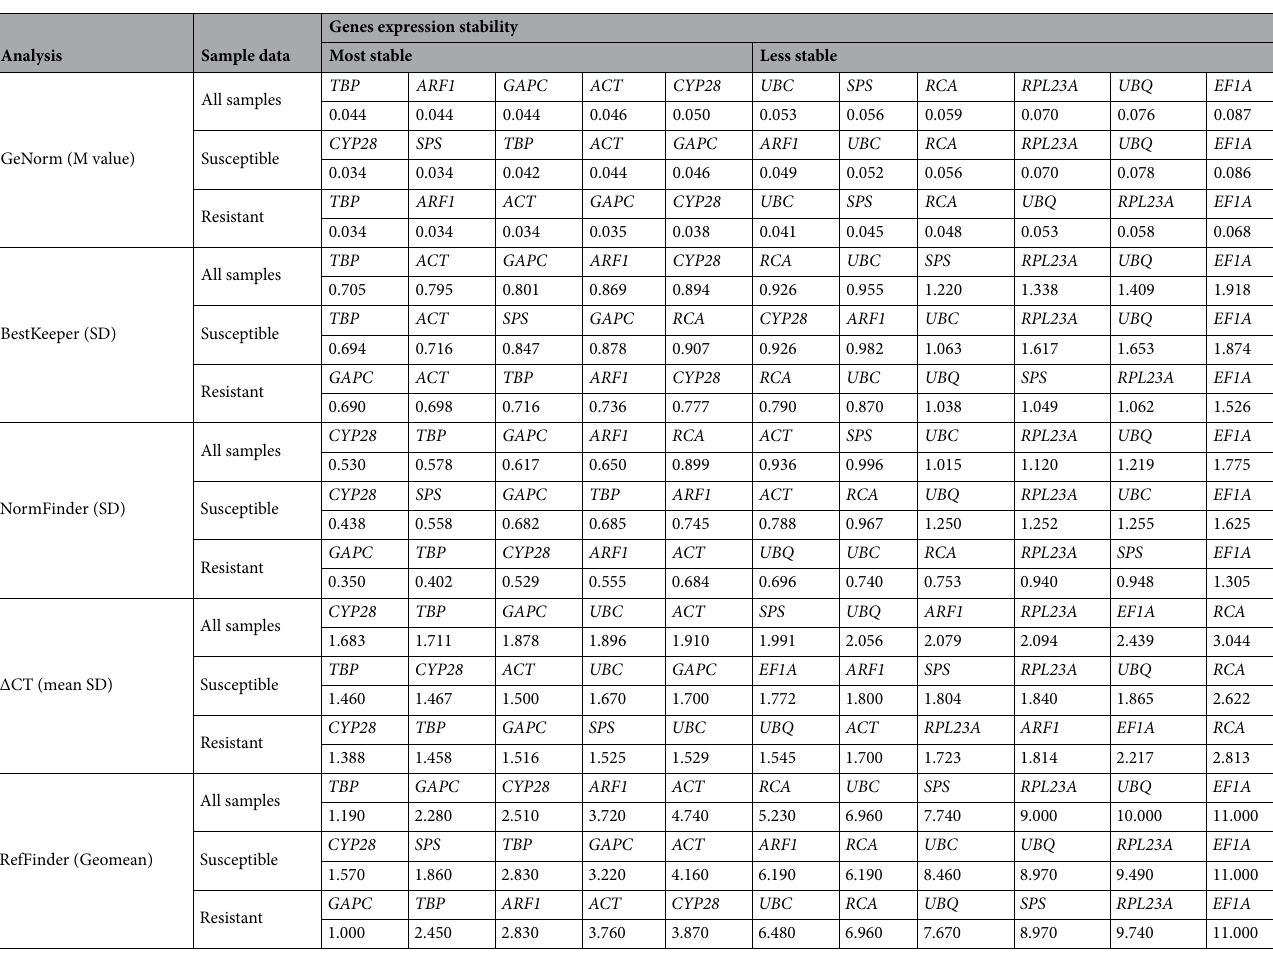
Table 2. Expression stability ranking of eleven candidate genes in Apera spica-venti plants resistant and susceptible to pyroxsulam. The input data for the geNorm, BestKeeper, ΔC t , and RefFinder calculations were the raw Cq